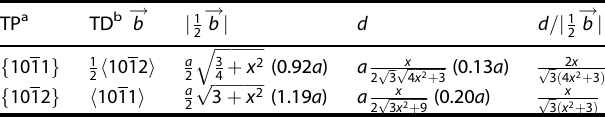
The parameter a is the lattice constant, x = c / a . Data for Mg are given in